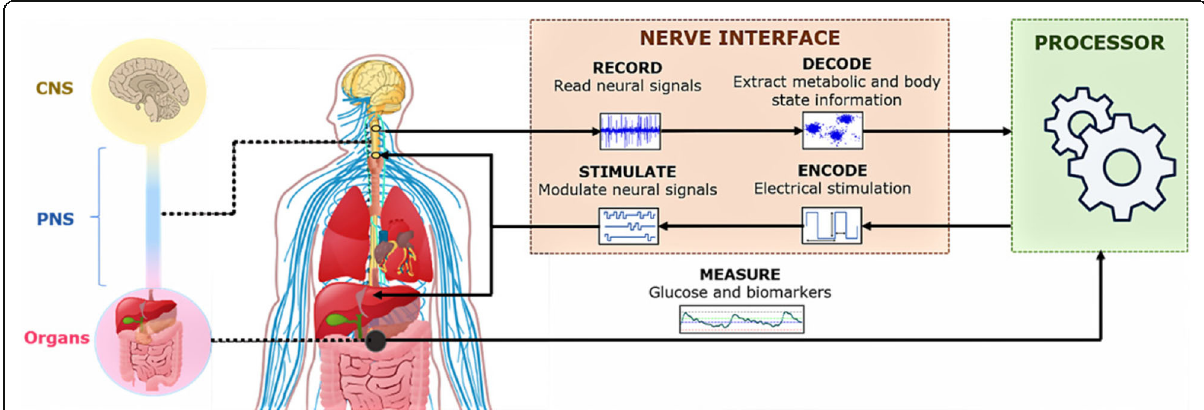
Fig. 1 A depiction of future closed-loop neuromodulation systems for diabetes management. Metabolic biomarkers and neurophysiological recordings from a variety of peripheral nerves can be used to automatically control the stimulation dosage to be delivered back to the peripheral nervous system or directly to the organs to modulate their